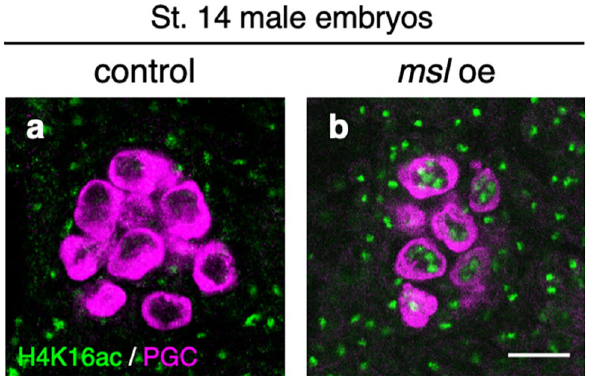
Figure 3. Overexpression of msl-1 , msl-2, msl-3 , and roX2 induces H4K16ac in male PGCs. ( a and b ) H4K16ac expression in male PGCs of nos-Gal4 strain ( a ; control) and male PGCs overexpressing msl-1 , msl-2, msl-3 , and roX2 ( b ; msl oe) at embryonic stage 14. Embryos were stained for H4K16ac (green) and Vasa (magenta). Embryos were sexed based on H4K16ac staining in the soma. Scale bar: 10